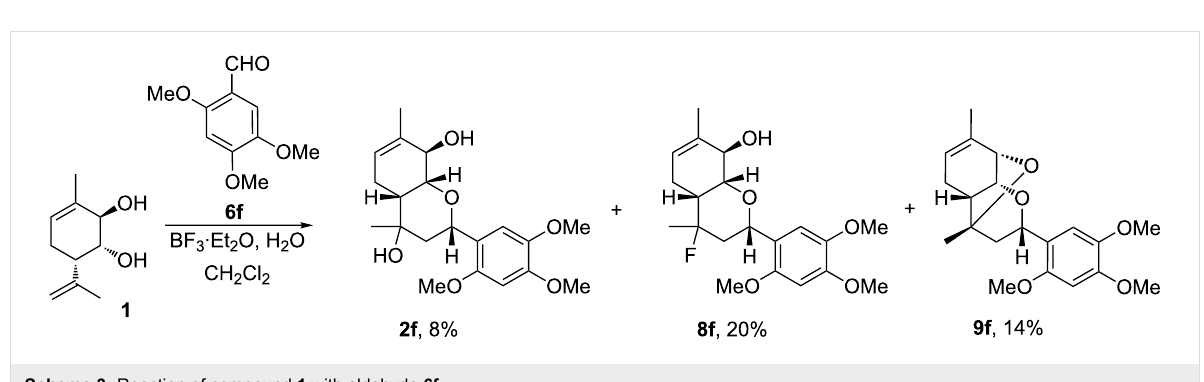
Scheme 3: Reaction of compound 1 with aldehyde 6f